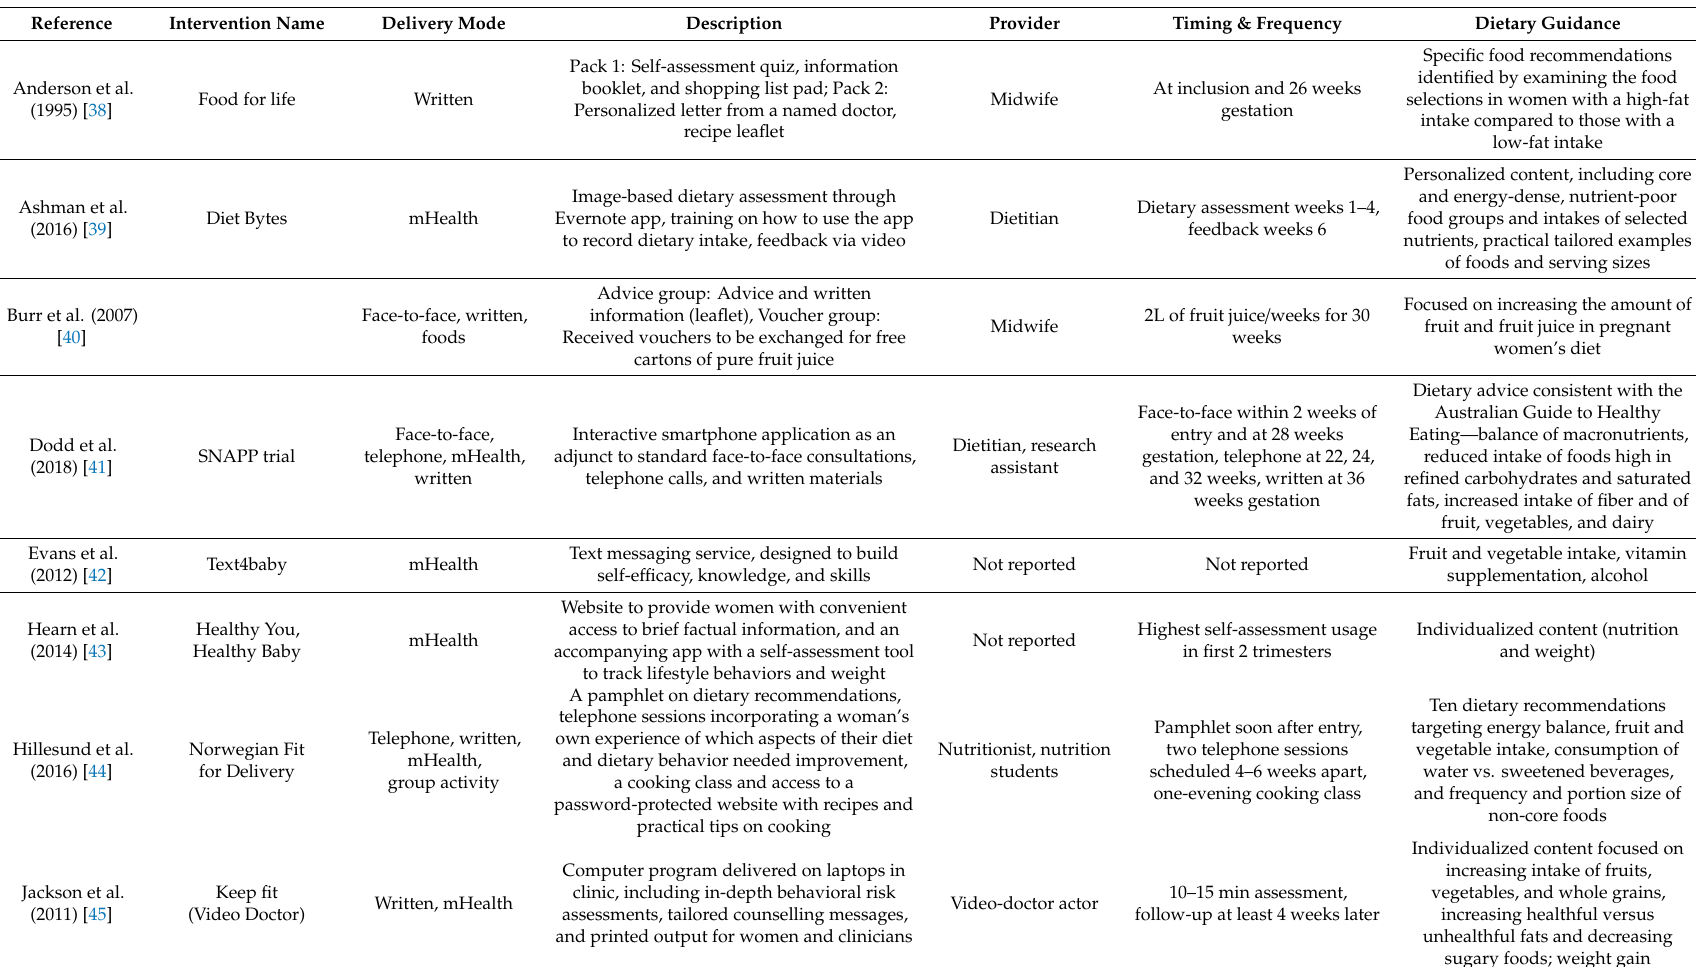
Table 3. An overview of interventions, tools, and characteristics of